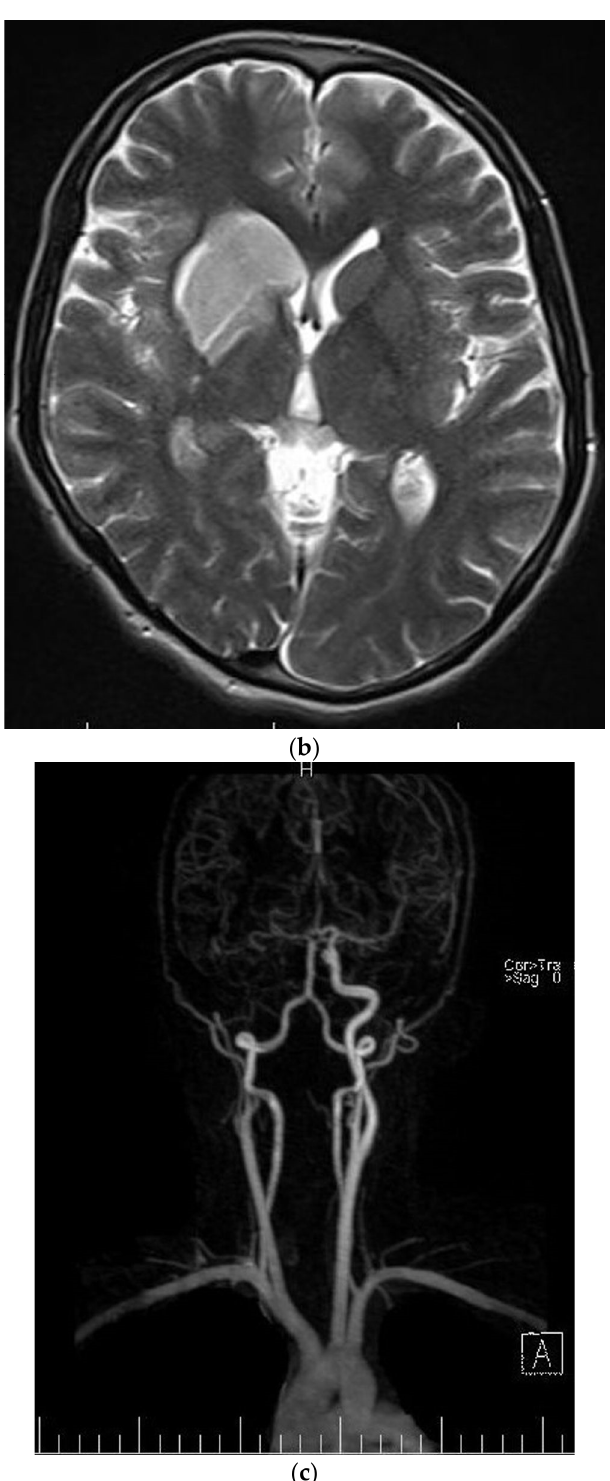
Figure 4. Axial ( a ) CT scan and MRI ( b ) and MR angiography ( c ) showing total occlusion of the right carotid artery along with a lesion in basal ganglia.